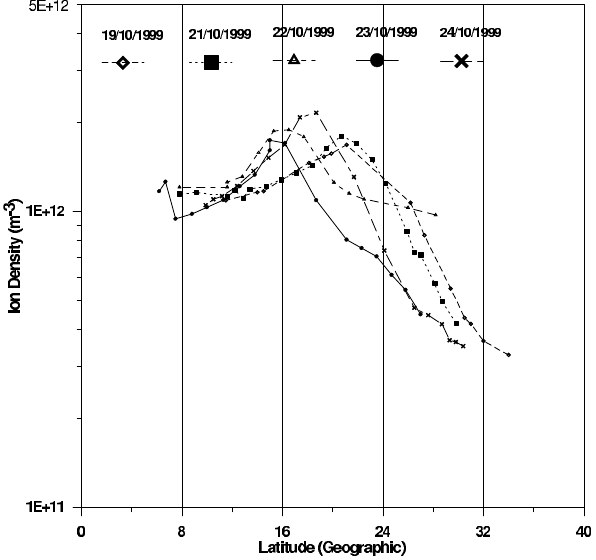
Fig. 6. Latitudinal variation of ion density observations made by the SROSS-C2 satellite during the period of storm IV. The longitude range covered by each pass is given in Table